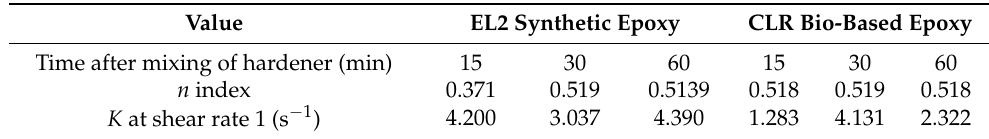
Table 2. Results of the power law model. Value EL2 Synthetic Epoxy CLR Bio-Based Epoxy Time after mixing of hardener (min) 15 30 60 15 30 60 n index 0.371 0.519 0.5139 0.518 0.519 0.518 K at shear rate 1 (s − 1 ) 4.200 3.037 4.390 1.283 4.131